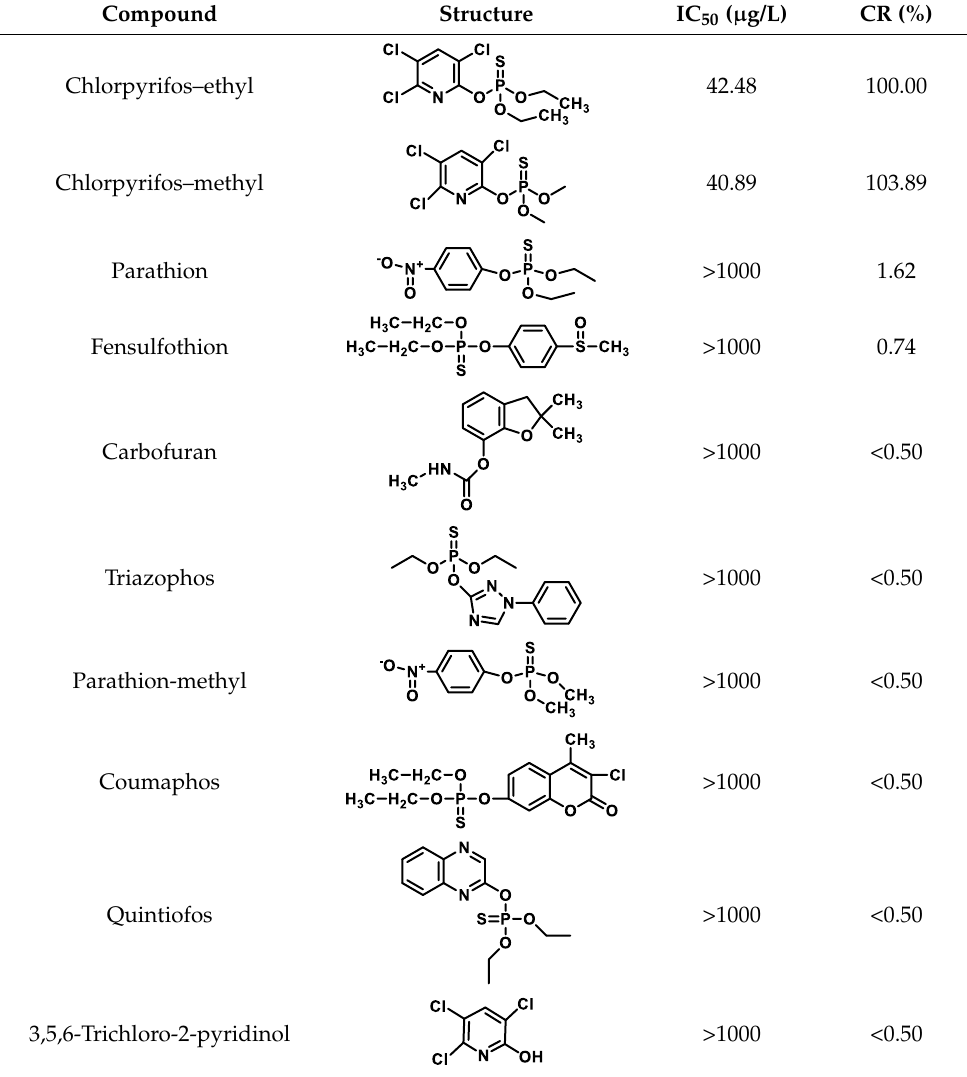
Figure 3. ( a ) The morphology of cells after fusion. ( b ) Calibration curve for determination of CPSE. Table 1. Specificity evaluation of mAb.